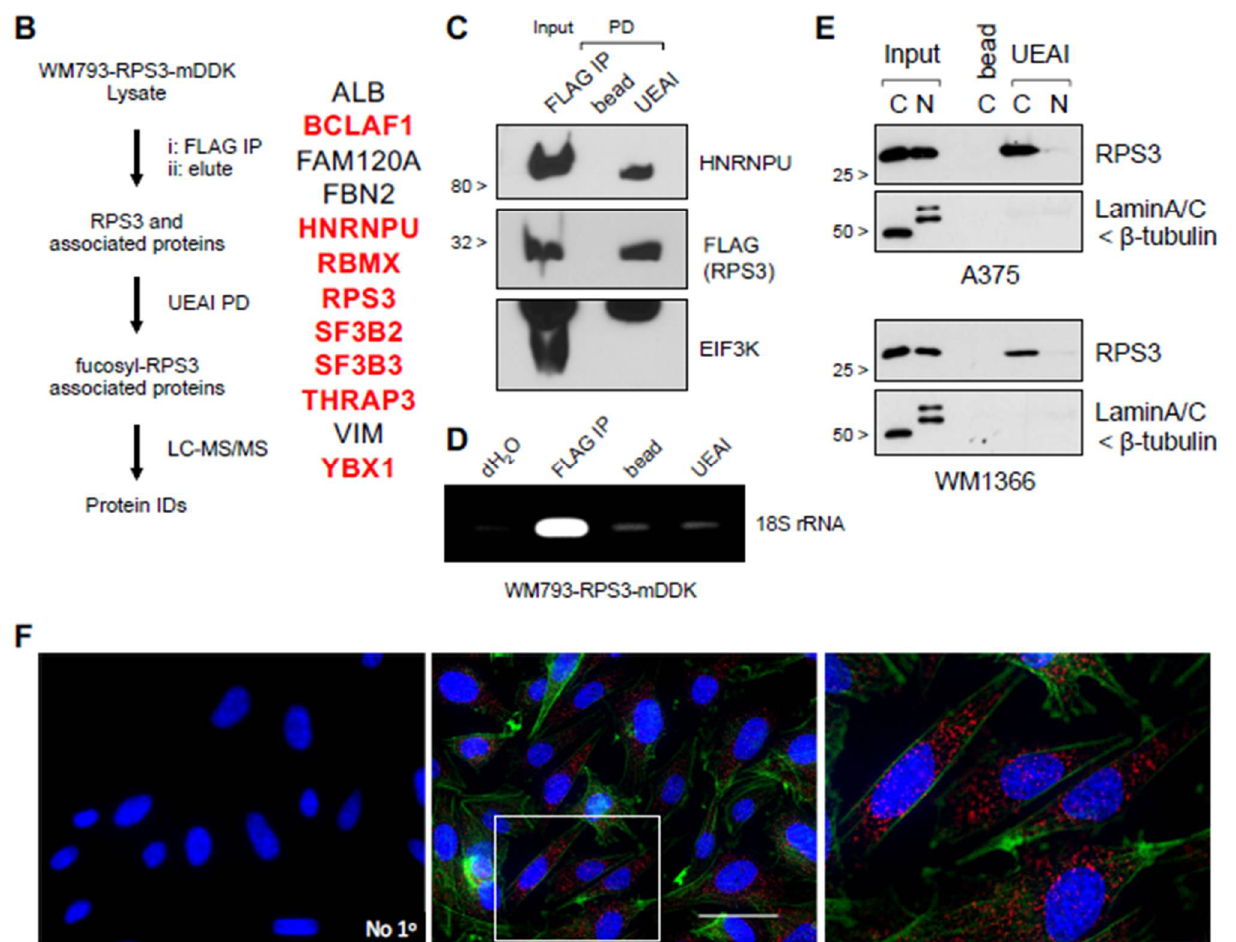
Figure 3. Fucosylated RPS3 interacts with a ribosome-independent group of proteins associated with posttranscriptional control of RNA. ( A ) RPS3 BioID lysates analyzed by Western blot to show specific biotin labeling of proteins and Neu-IP capture in cells expressing RPS3-BirA versus BirA expression alone. Neu-IP captured proteins identified by LC-MS/MS analysis were found to segregate into three groups by STRING analysis: (i) ribosome-associated proteins (red), (ii) posttranscriptional RNA regulators (green), and (iii) proteins not strongly associated with either group (i) or (ii). ( B ) Workflow to identify proteins associated specifically with fucosylated RPS3. LC-MS/MS identified 12 proteins, a majority of which are known to interact amongst each other (highlighted in red) and posttranscriptionally regulate RNA. ( C ) Validation of interaction between RPS3 and HNRNPU. Analysis of FLAG IP elution of RPS3-mDDK (step 2 in panel B) and subsequent UEAI-PD for HNRNPU, FLAG (RPS3), and EIF3K (to confirm ribosome-independent interaction). ( D ) RNA immunoprecipitation analysis of FLAG IP elution and subsequent UEAI-PD was assessed for interaction with small ribosomal RNA (18S rRNA). ( E ) Cells were harvested for cytoplasmic (C) and nuclear (N) fractions prior to UEAI-PD to determine localization of fucosylated RPS3. Lamin A/C and β -tubulin were probed as markers for the nuclear and cytoplasmic fraction, respectively. ( F ) Cells were grown on glass coverslips and fixed for proximity ligation analysis (PLA) of RPS3 and UEAI lectin (Red). Cells were stained with phalloidin (Green) to visualize the cytoplasmic region and DAPI to visualize the nuclear region. PLA with no primary antibodies (No 1 ◦ ) was run as a negative control. RPS3-UEAI-positive foci were found to be localized primarily to the cytoplasmic